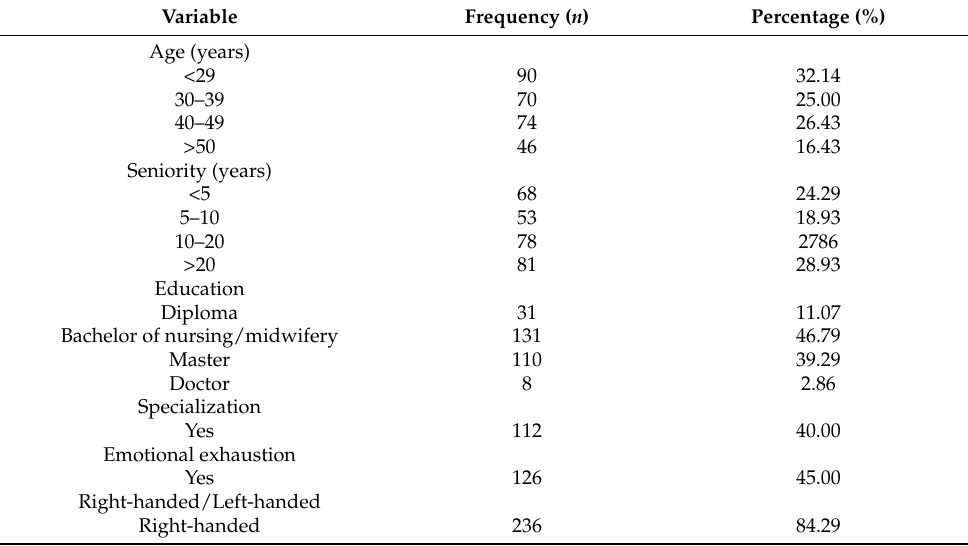
Table 1. Characteristics of the included nurses (N = 280).